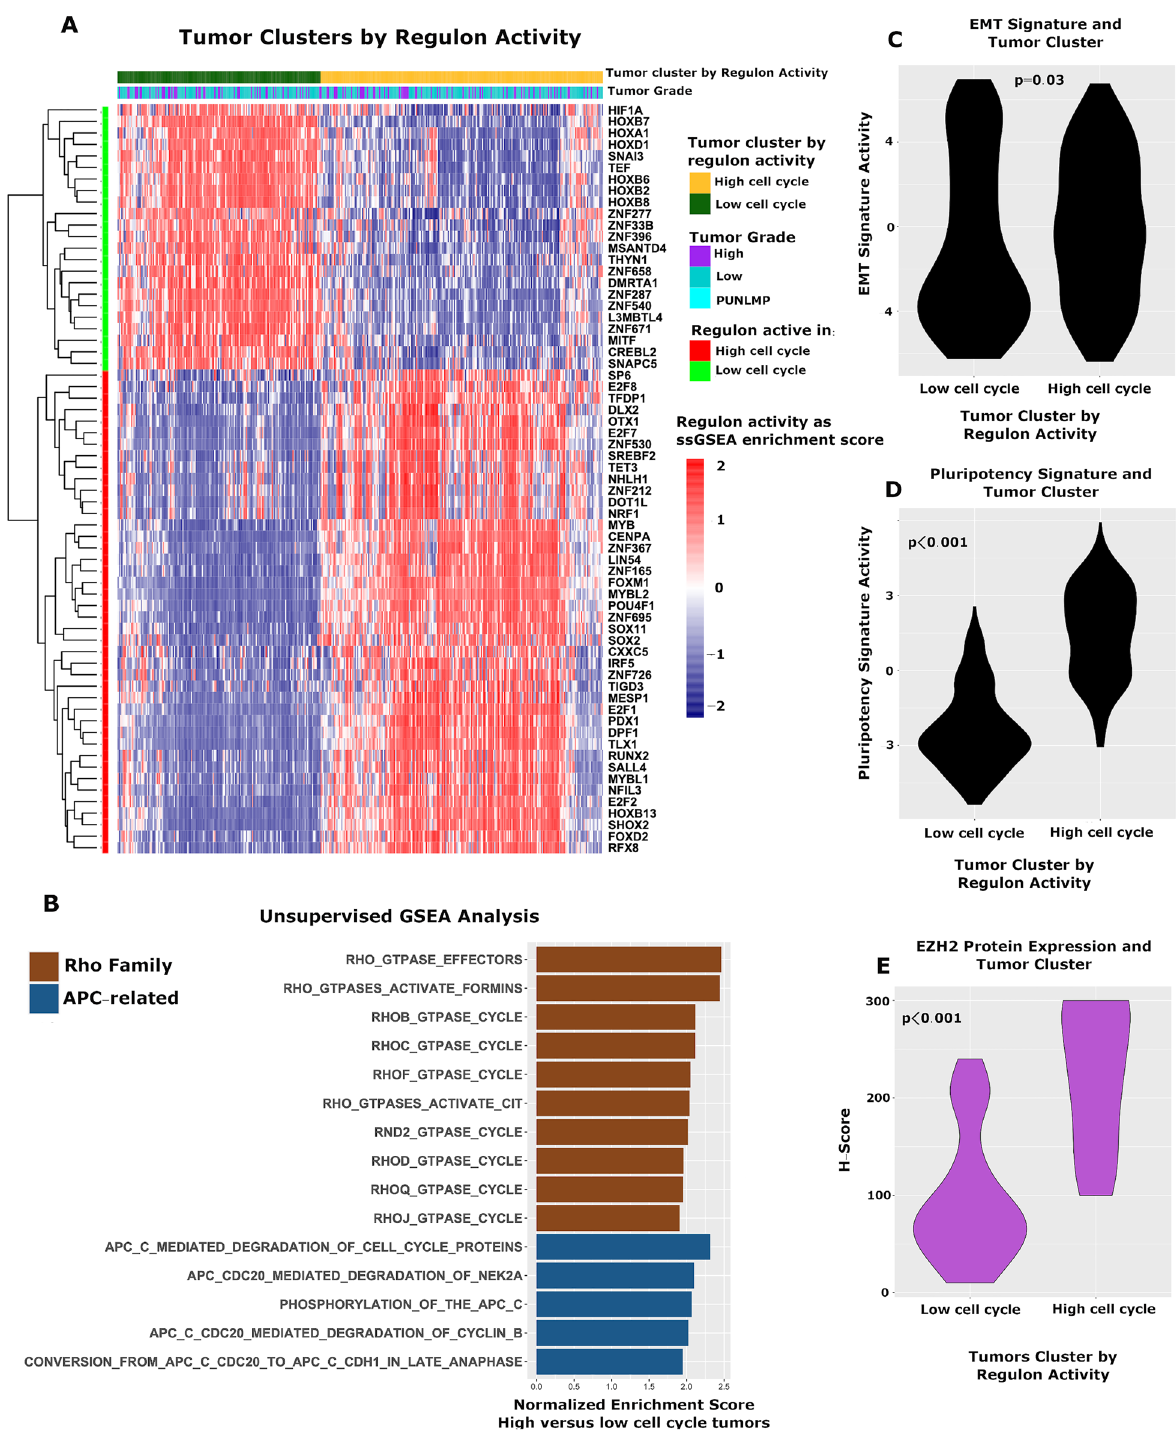
Figure 2. Activity of TF regulons and activity of cellular pathways, EMT, and pluripotency signatures. ( A ) Consensus clustering divided tumors into High Cell Cycle and Low Cell Cycle groups, which differed in regulon activity. ( B ) GSEA demonstrated tumors in the High Cell Cycle group had greater activity of multiple signatures, most notably signatures in the Rho family and APC pathway. Tumors in the High Cell Cycle group demonstrated greater activity of established EMT ( C ) and Pluripotency ( D ) signatures 20,21 , and expressed higher levels of the PRC2 member EZH2 at the protein level by immunohistochemistry ( E ). ( A – D from Cohort 2, E from Cohort